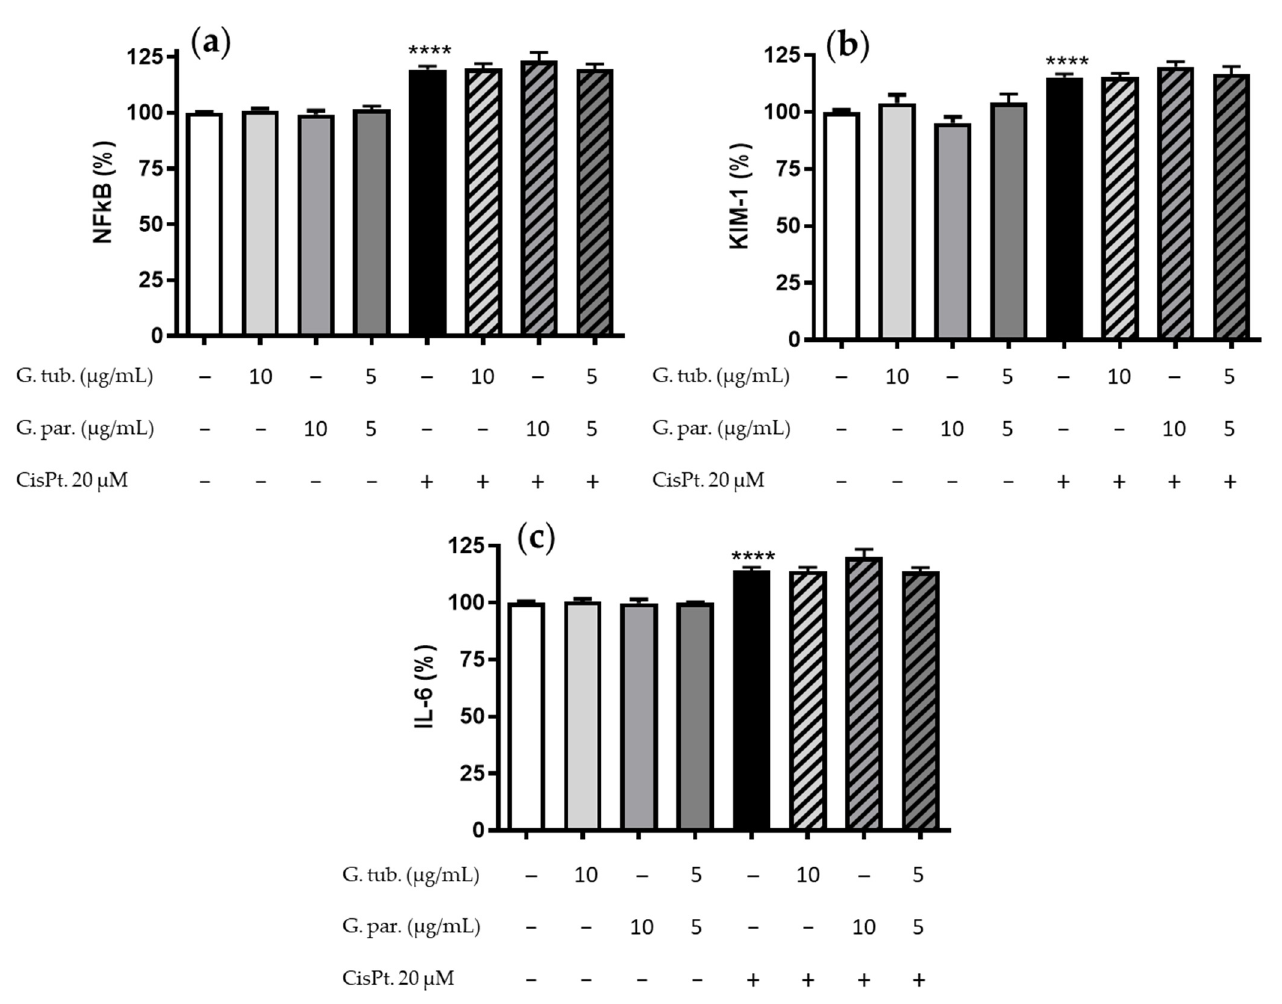
Figure 4. Anti-inflammatory measurements of immunostained cells after a 24 h treatment with CisPt 20 µM and/or the G. tub. extract (10 µg/mL); the G. par. extract (10 µg/mL) or the G. tub. and G. par. association extract (each at 5 µg/mL). Three markers were analyzed and their normalized fluorescences compared to controls are shown as follows: ( a ) intracytoplasmic NF κ B proportion, ( b ) membranous KIM-1 proportion, and ( c ) intracytoplasmic IL-6 proportion. Results are shown as mean ± SD of three independent experiments (**** p < 0.0001 compared to controls). The signs + and − indicate the presence or the absence of the corresponding treatment, respectively.